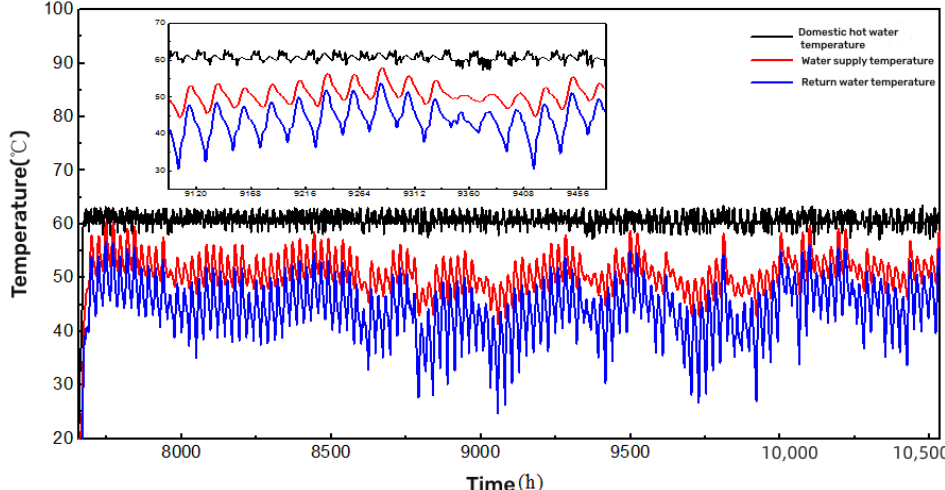
Figure 4. Temperature of the system’s supply and return water and domestic hot water.